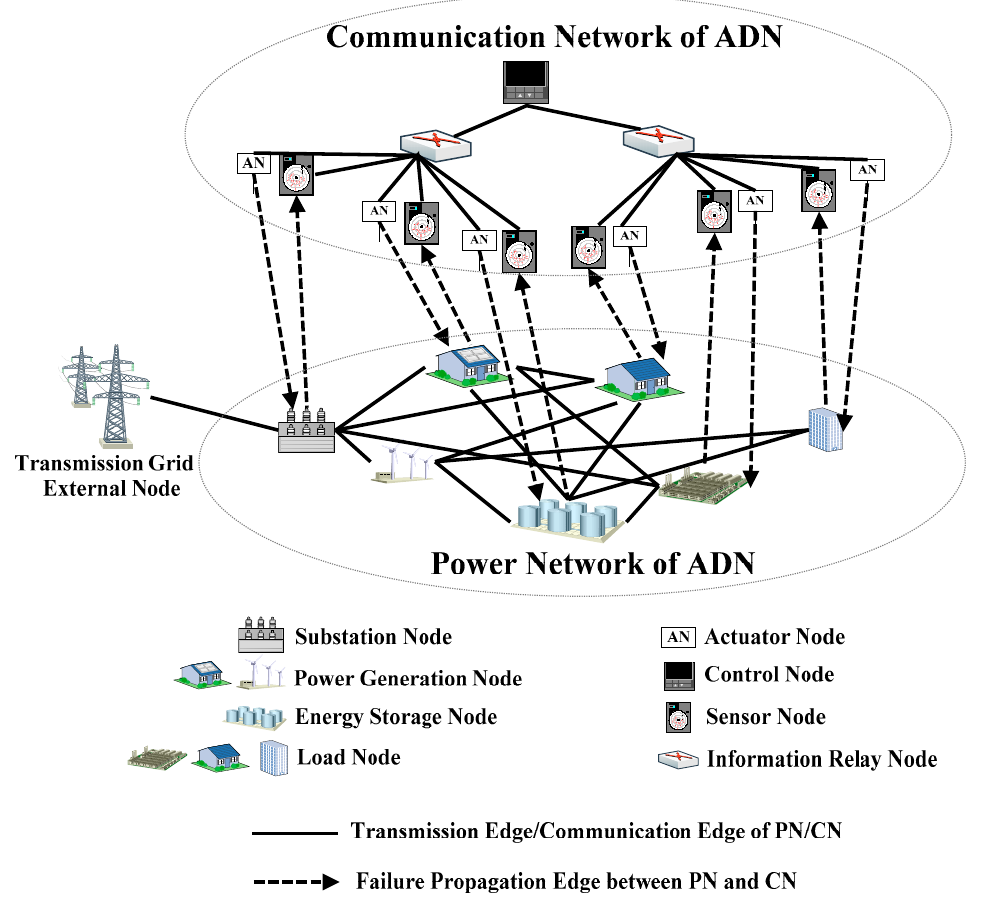
Figure 1. A brief architecture of an active distribution network (ADN).